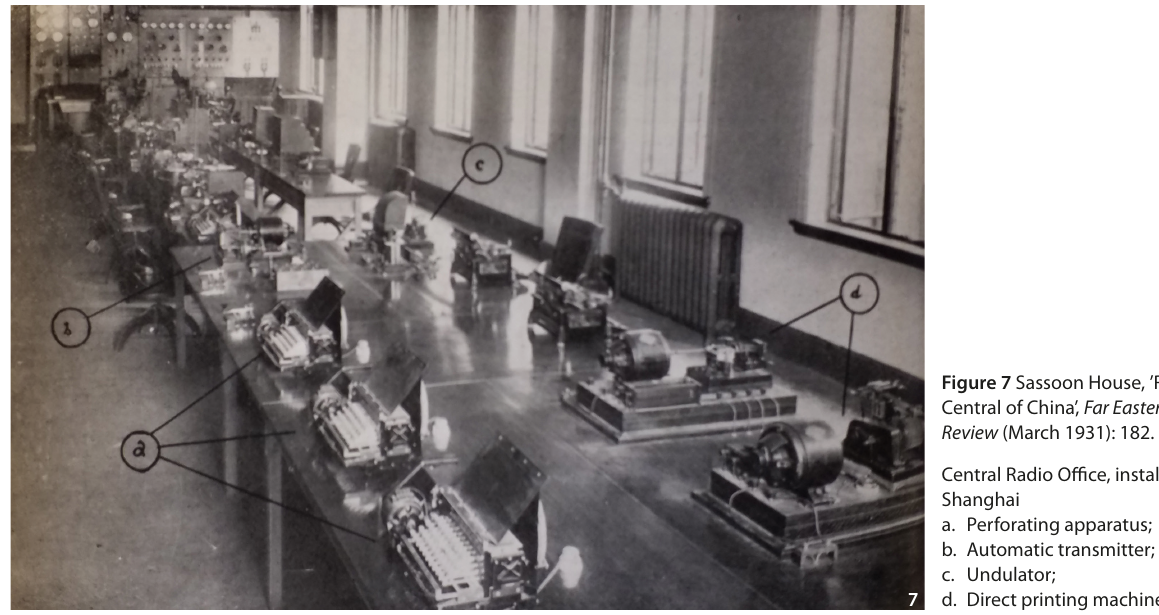
Figure 7 Sassoon House, ’Radio Central of China’, Far Eastern Review (March 1931):